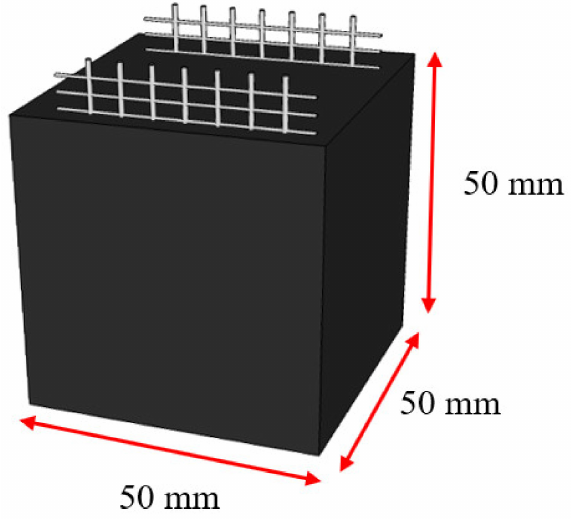
Figure 1. Schematic of a nanocementitious